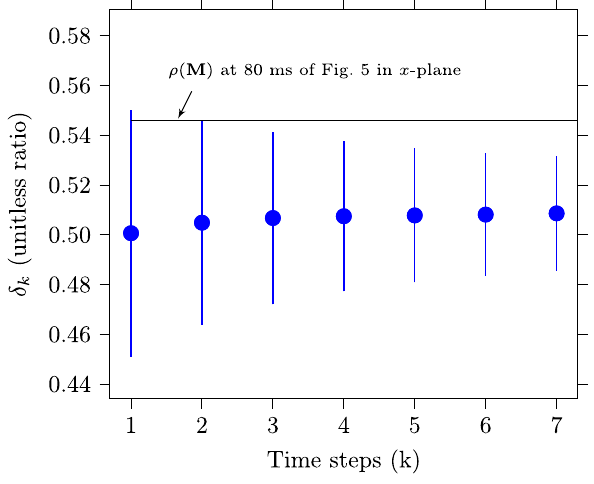
r k; RMS w Þ 1 k over subsequent k ¼ ð 0 ; RMS